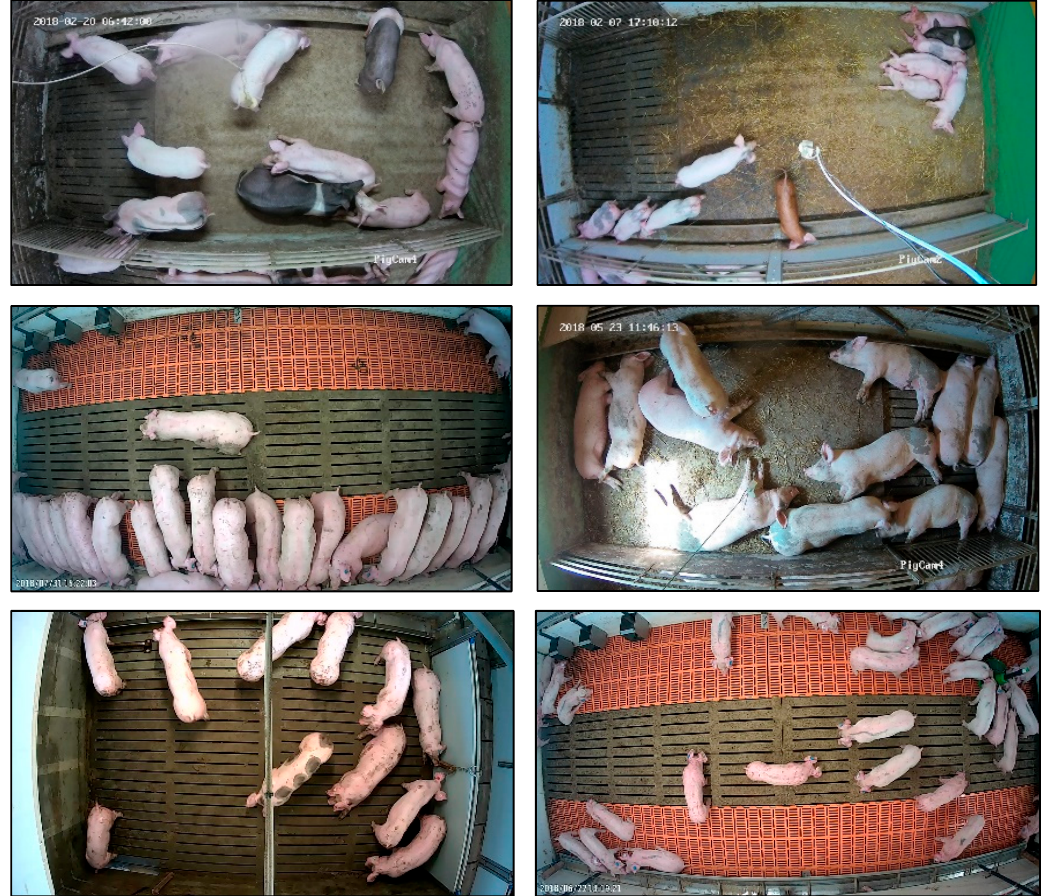
Figure 1. Example of images used for development of the detection algorithms in this study.